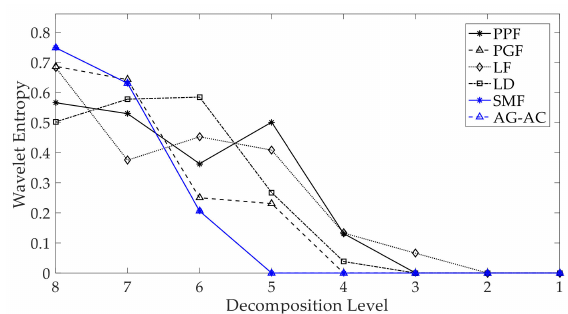
Figure 12. Wavelet entropies of different